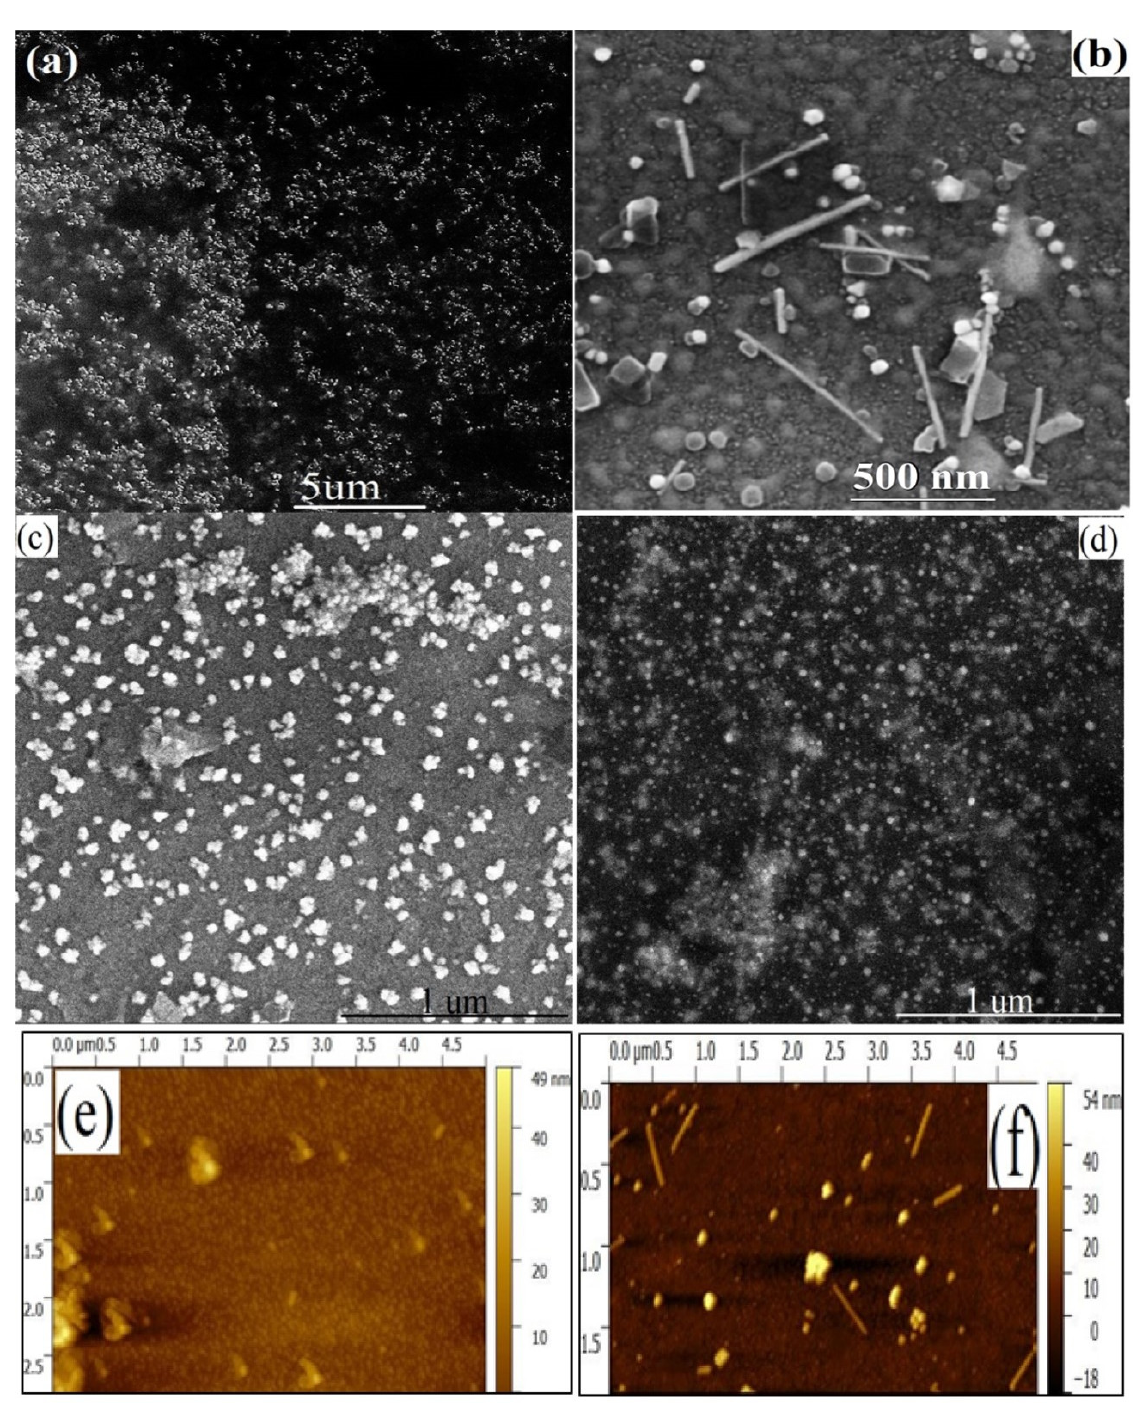
Figure 1. FESEM images of surface morphology of ( a ) Au bilayer ( b ) AuNCs/APTMS/ITO in ( c ) acTnI/Cys/AuNCs/APTMS/ITO and ( d ) BSA/acTnI/Cys/AuNCs/APTMS/ITO at a magnification of 10 kx, 100 kx and 60 kx respectively AFM image of ( e ) Au Bilayer ( f ) AuNCs/APTMS/ITO AFM images of surface topography for 2.5 μm × 5 μm area and 1.5 μm × 5 μm of developed electrode, respectively.